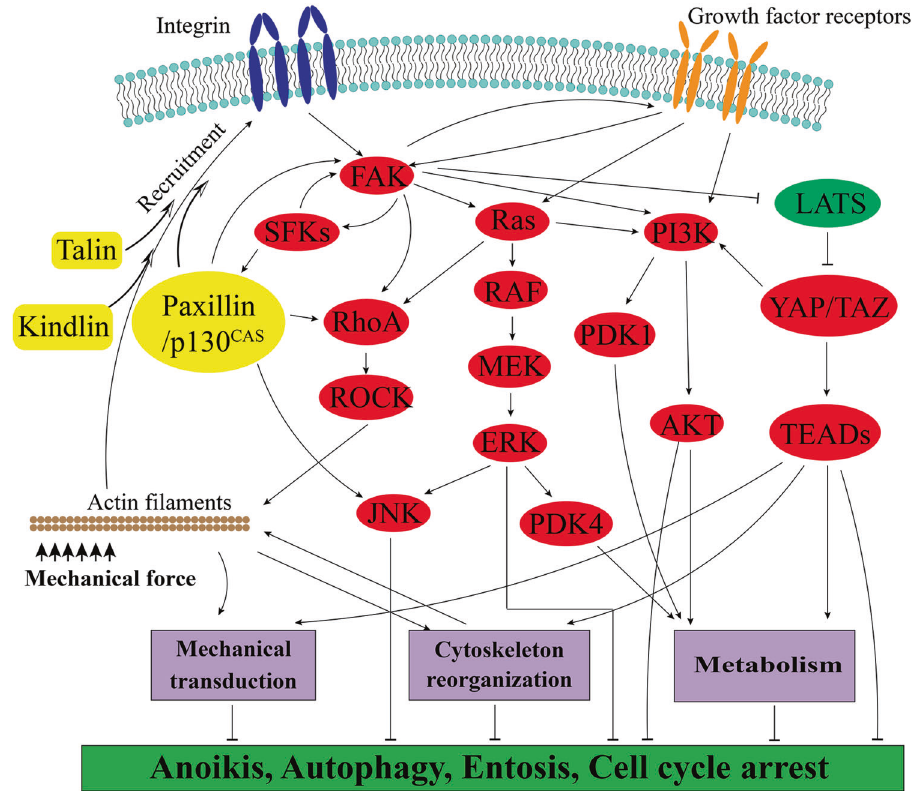
Fig. 2 Molecular pathways sustaining anchorage-independent survival. During detachment, the ligand – integrin interaction between cells and ECM is disrupted and the cells lose the growth stimuli from ECM. However, the integrin can be also stimulated by mechanical force and cytoskeleton reorganization that actin fi laments recruit integrin adaptor proteins, such as talin, kindlin, paxillin, and p130 CAS to integrin, hence inducing integrin clustering and activation. The activated integrin induces FAK/SFK activation and its downstream signaling proteins. There is also crosstalk between FAK/SFK and growth receptor signaling, such as EGFR, PDGFR, VEGFR, and IGFR signaling pathway. In cooperation with growth receptor signaling, integrin/FAK/SFKs induces Paxillin/p130 CAS /JNK, Ras/ERK, PI3K/AKT, YAP/TAZ, and RhoA/ROCK signaling activation, and hence regulate mechanical transduction, cytoskeleton reorganization, and metabolism. Noteworthy, there is also crosstalk between these downstream signaling pathways. Eventually, activated integrin signaling and its downstream signaling inhibits various forms of cell death, including anoikis, autophagy, cell cycle arrest and